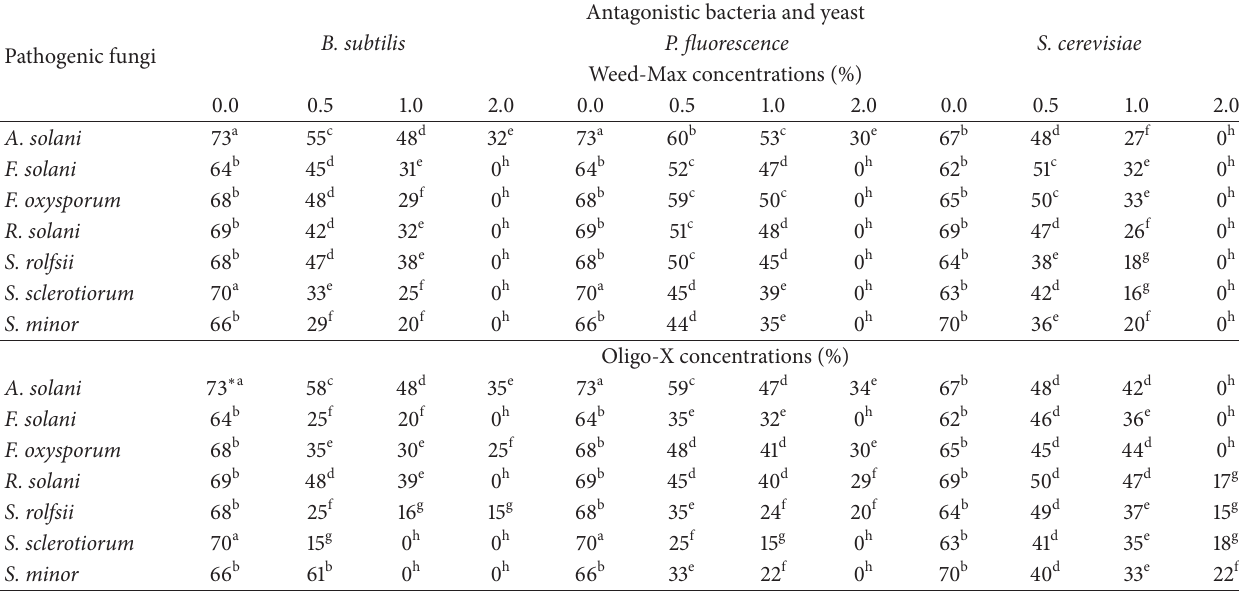
Table 4: Effect of Weed-Max and Oligo-X on the antagonistic ability of bacteria and yeast against some soil-borne pathogenic fungi in vitro .